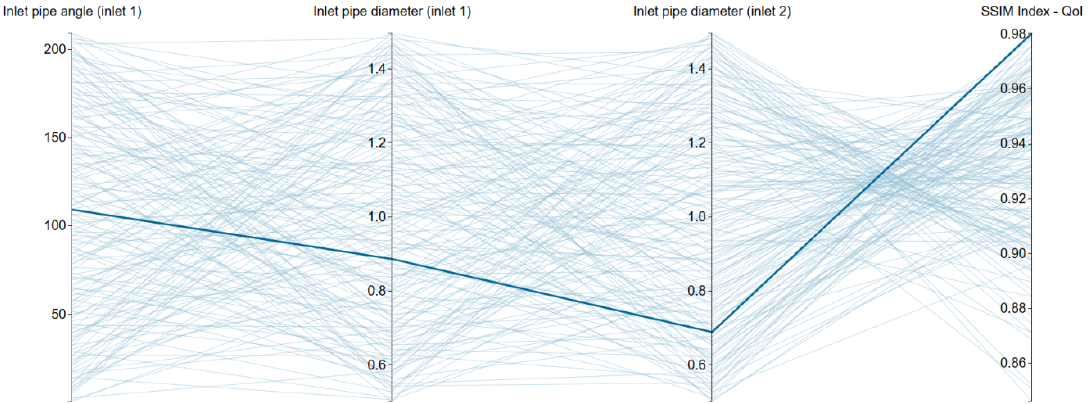
Figure 12. Parallel coordinates plot of the outcome of the DSE study using three design variables. The highlighted line represents the best